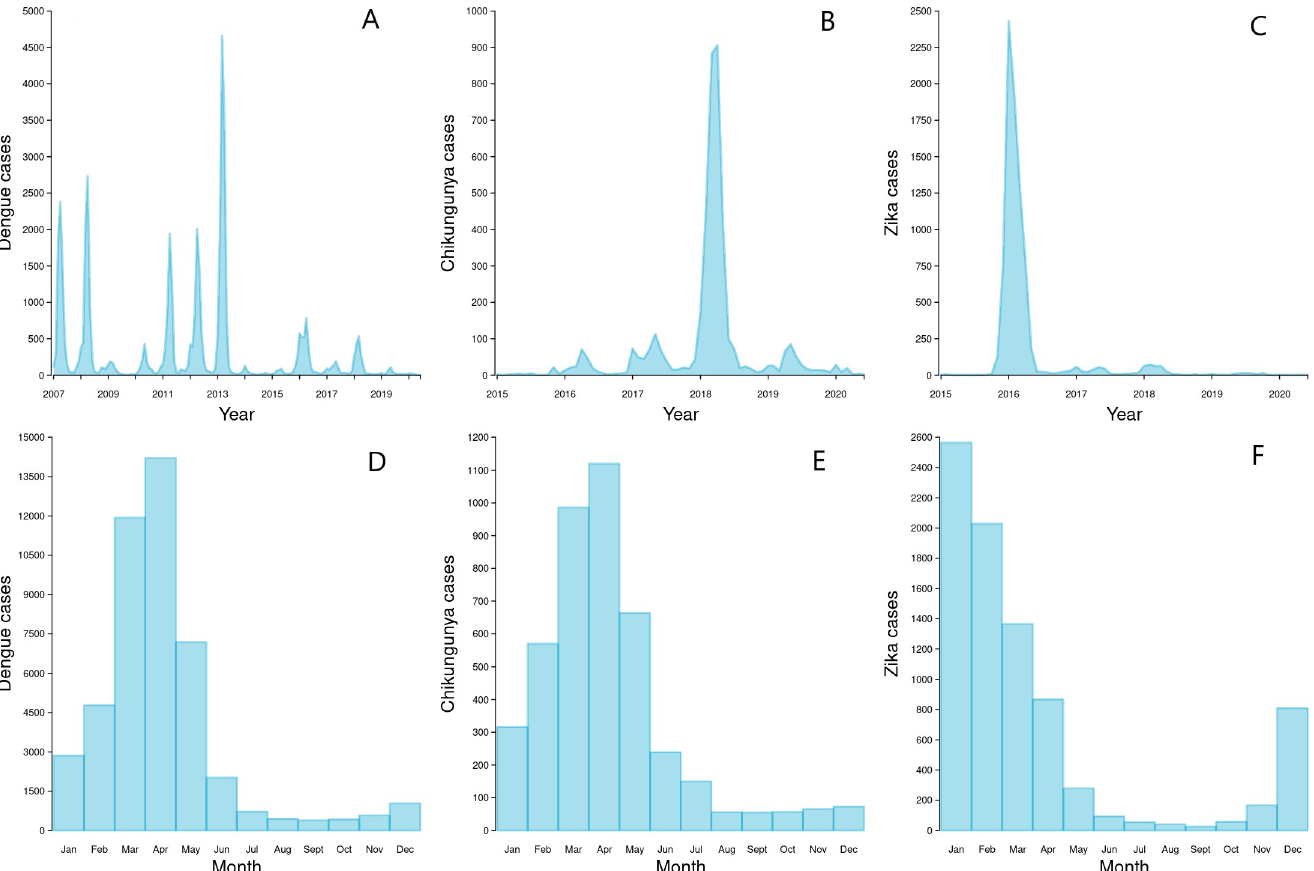
Fig 3. Dengue, chikungunya and Zika time series and seasonality in Nitero´i. Monthly dengue (A), chikungunya (B) and Zika (C) case notifications in Nitero´i from January 2007 (dengue) or January 2015 (chikungunya/Zika) to June 2020, and dengue (D), chikungunya (E) and Zika (F) case notifications aggregated by calendar month, across the same